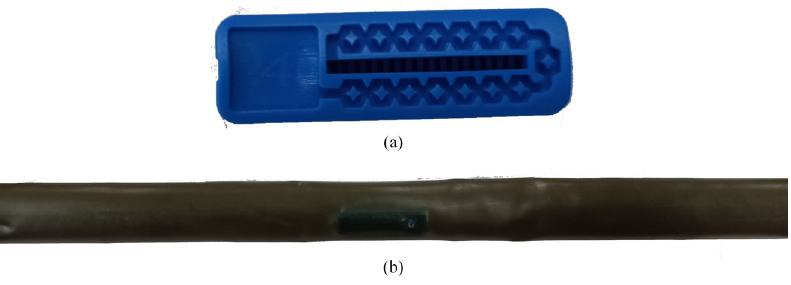
Figure 7. ( a ) SWRLC emitter; ( b ) drip irrigation belts.